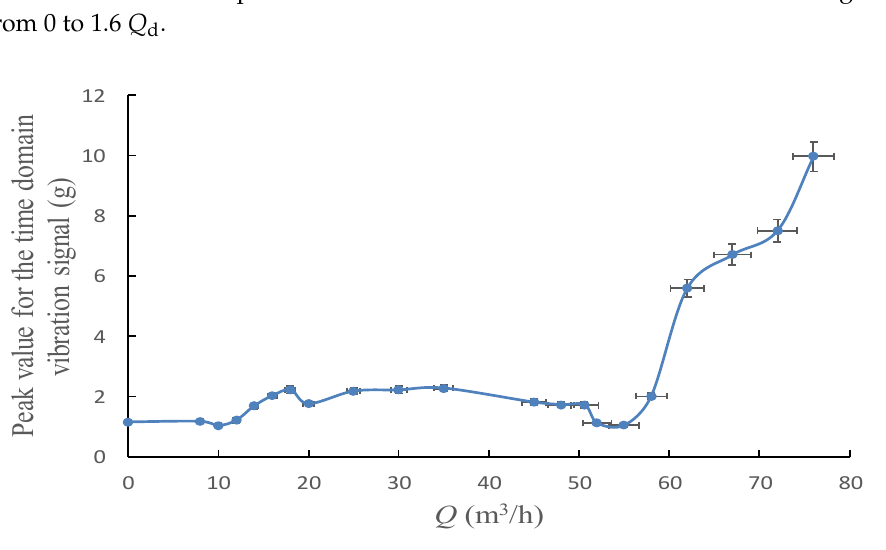
Figure 8. Peak for the time domain vibration signal under different flowrates.